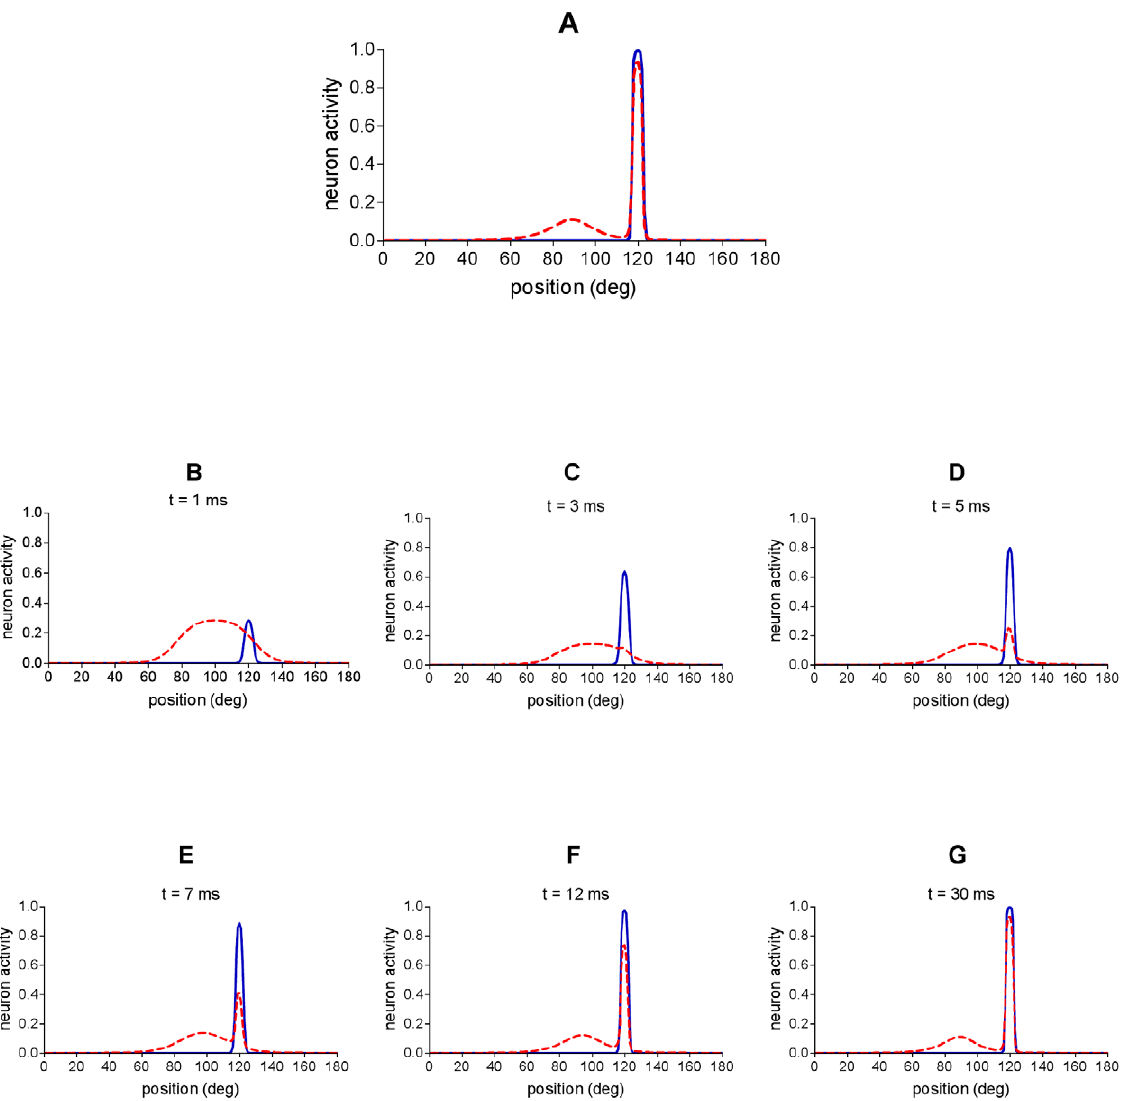
Figure 3. Network response to audio-visual stimulation with spatially disparate stimuli. An auditory stimulus and a visual stimulus are simultaneously applied at two different spatial positions ( p a =100 u , p v =120 u ) and maintained constant throughout the simulation. Auditory and = E a =15). Dashed red line represents activity in the auditory area; continuous blue line represents activity visual stimuli have the same strength ( E v 0 0 in the visual area. ( A ) Network activity in the final steady-state reached by the network. ( B–G ) Different snapshots of network activity during the simulation. First snapshot (B) depicts network activity immediately after the stimuli presentation; last snapshot (G) corresponds to the final state reached by the